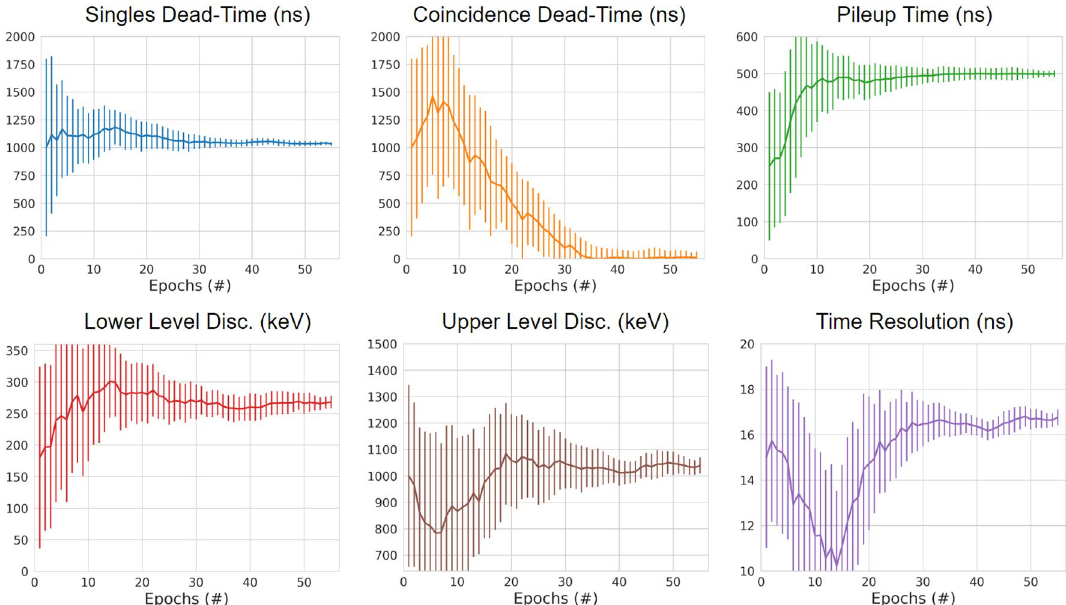
Figure 8. The mean parameter value guesses for each of the six free parameters with the standard deviation of the guesses are plotted as error bars. After 56 epochs all parameters are below 10% standard deviation and the optimisation is